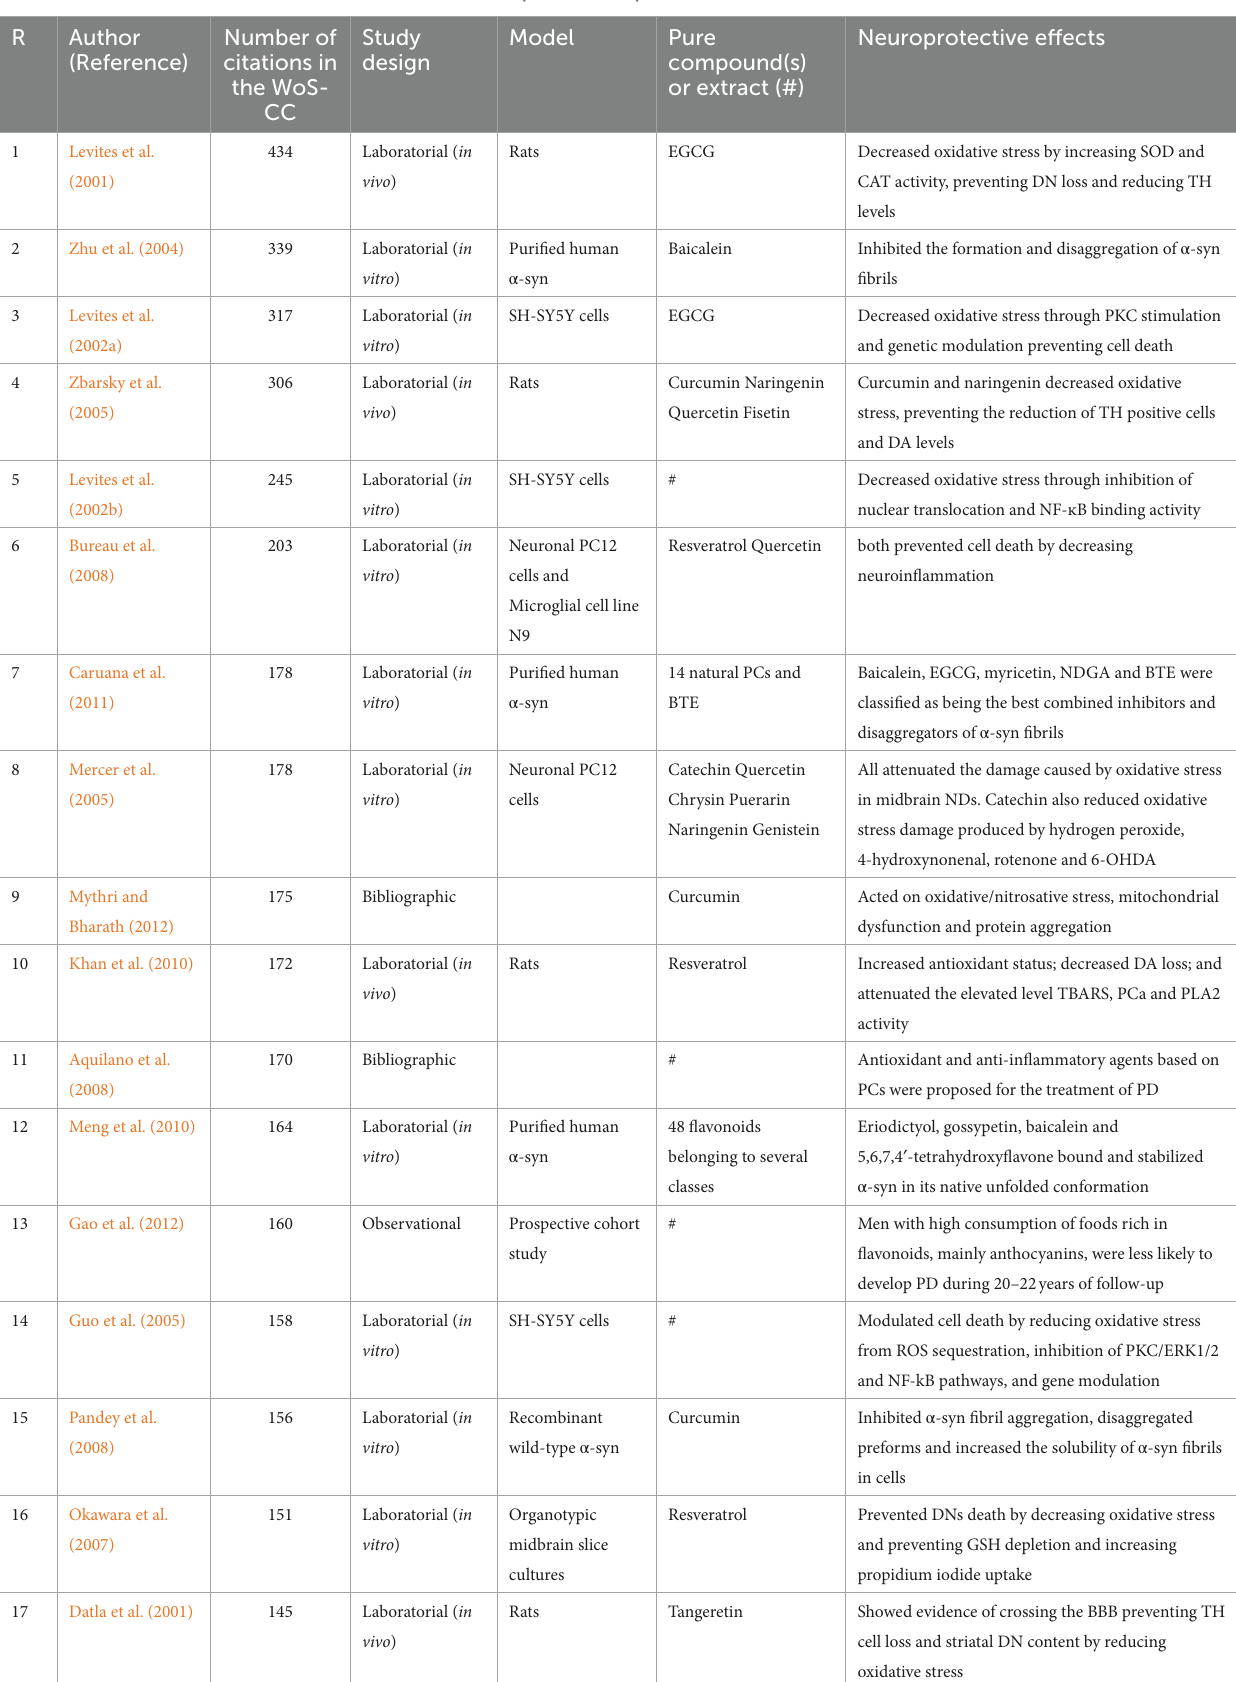
TABLE 2 The 100 most cited articles on Parkinson’s disease and phenolic